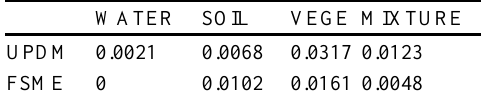
Table 1. Root mean square error (RMES) of the universal pattern decomposition method (UPDM)